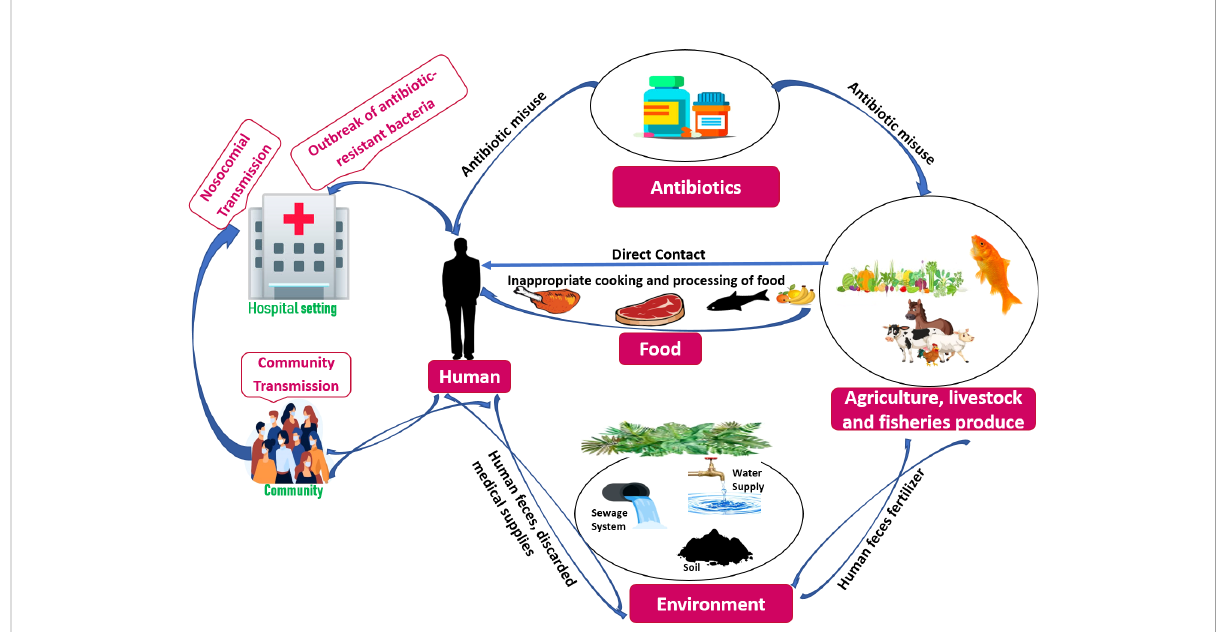
FIGURE 1 Factors contributing towards Antibiotic-Resistance (ABR) within One Health